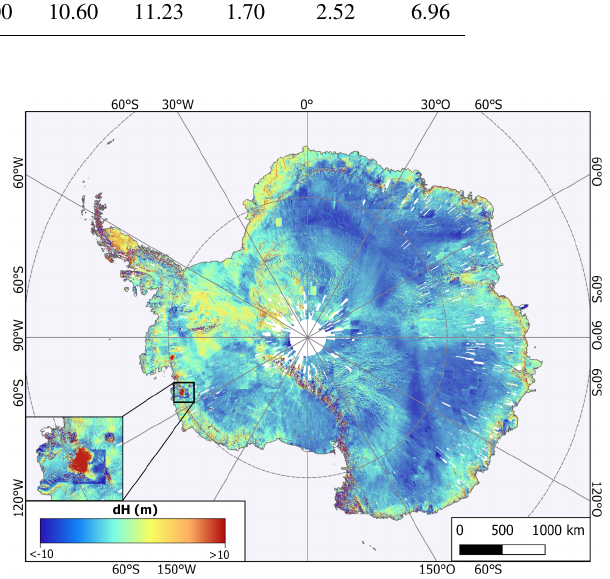
Figure 18. Height difference of TanDEM-X DEM minus